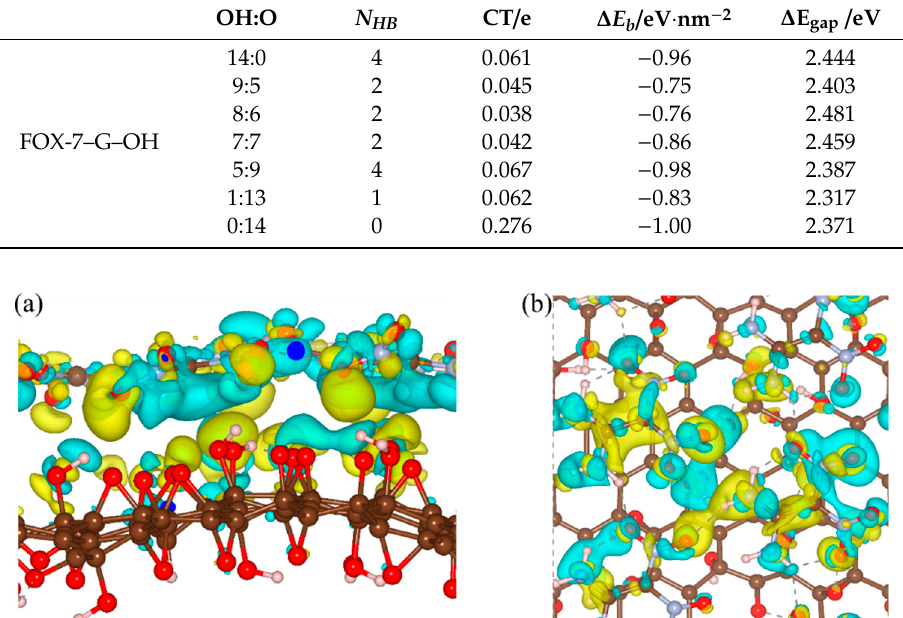
Table 2. The number of interfacial hydrogen bonds ( N HB ), charge transfer from GO to FOX-7 monolayer (CT), binding energies ( Δ E b ), and band gaps ( Δ E gap ) of FOX-7 monolayer in composites with different OH:O ratios.